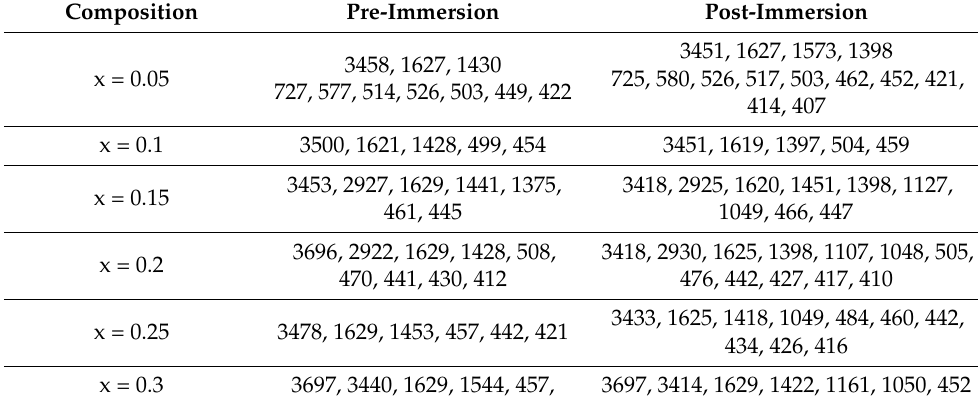
Table 2. The vibration bands for the investigated samples before and after immersion in Xerostom ® . Composition Pre-Immersion